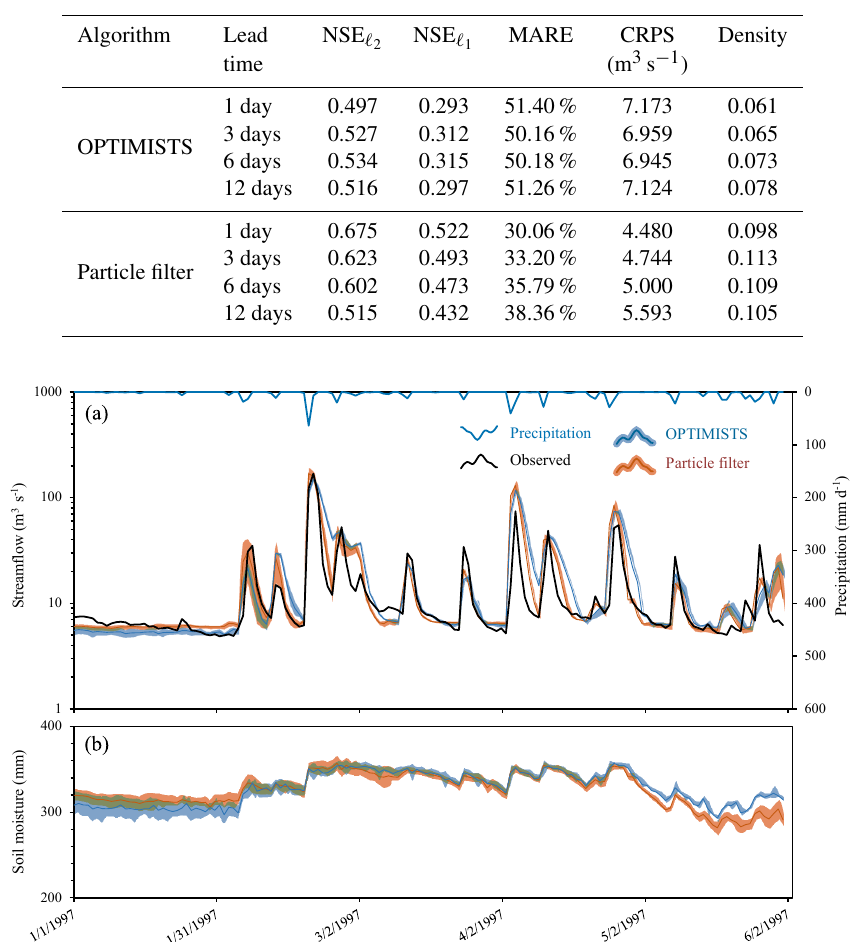
Table 5. Continuous daily streamflow forecast performance metrics for the Blue River application using OPTIMISTS ( (cid:49)t = 7 days; three ob- jectives: NSE (cid:96) , MARE, and likelihood; n = 30; no optimization; and D-class kernels) and a traditional PF ( n = 30). The continuous forecast 2 extends from January to June 1997. The NSE (cid:96) , NSE (cid:96) , and MARE (deterministic) are computed using the mean streamflow of the forecast 2 1 ensembles and contrasting it with the daily observations, while the CRPS and the density (probabilistic) are computed taking into account all the members of the forecasted ensemble.